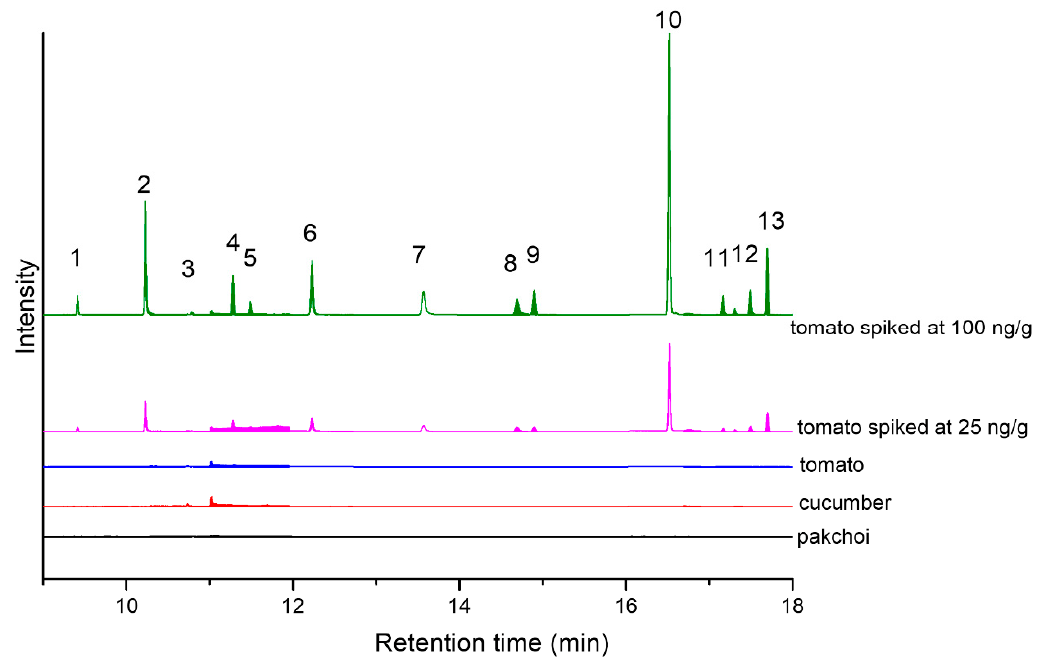
Figure 4. MSPE-GC-MS/MS chromatograms for spiked/un-spiked blank vegetables. The chromatogram peaks marked 1 to 13 represent isocarbophos, quinalphos, phorate, chlorpyrifos, phosalone, pirimor, carbaryl, myclobutanil, diniconazole, lambda-cyhalothrin, bifenthrin, 2, 4 ′ -DDT, and mirex, respectively.